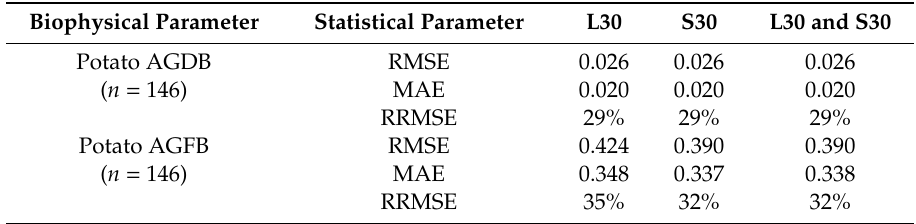
Table 10. Statistical comparison between modeled and observed above-ground dry biomass (AGDB) and above-ground fresh biomass (AGFB) for potato separated by satellite type: L30, S30, and L30 and S30 combined, modeled fresh and dry above-ground biomass is obtained from equations displayed in Figure 13 as a function of observed LAI. Biophysical Parameter Statistical Parameter L30 S30 L30 and